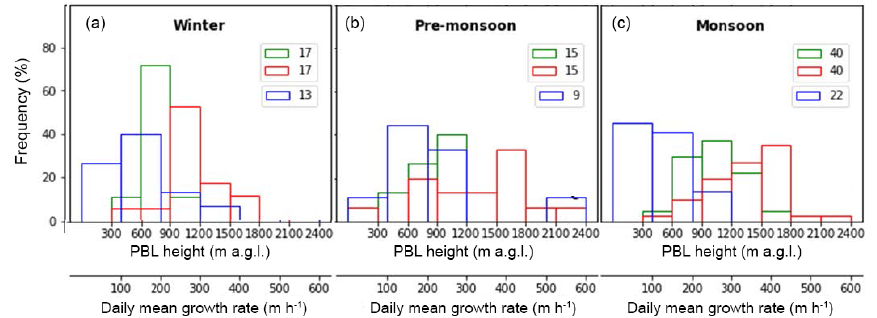
Figure 8. Frequency distribution of daily mean (green) PBLH, daily maximum PBLH (red) and daily mean growth rate (blue) as calculated during the winter period (a) , the pre-monsoon season (b) and the monsoon period (c) . Numbers indicate data availability.